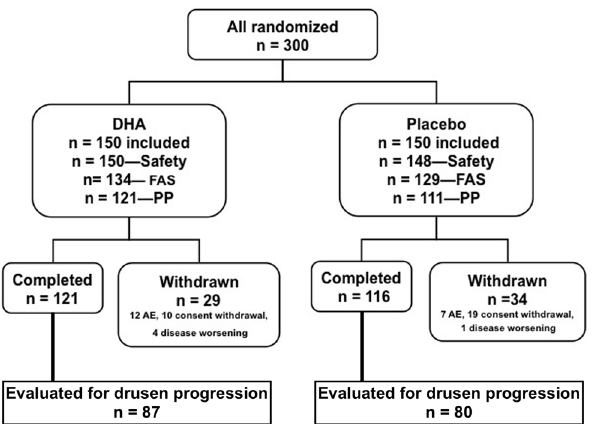
Fig 1. Diagram showing the study population. The safety population included all subjects who have received the study treatment. Full analysis set (FAS) included all subjects in the safety set who have had at least 1 post-baseline evaluation regarding occurrence of choroidal neovascularization. Per protocol (PP) population included all FAS subjects without major protocol deviation. Among those withdrawn there were 3 deaths in the docosahexaenoic acid (DHA) group and 6 deaths in the placebo group.